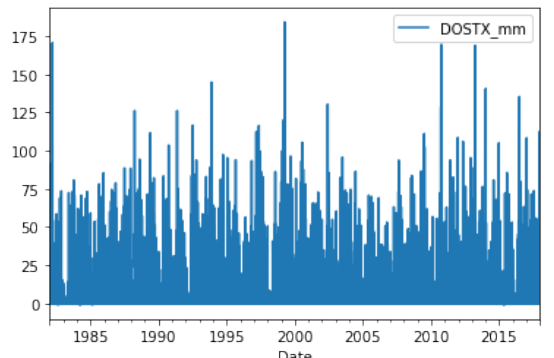
Figure 6. Heat Map 2017 Figure 5. Heat Map